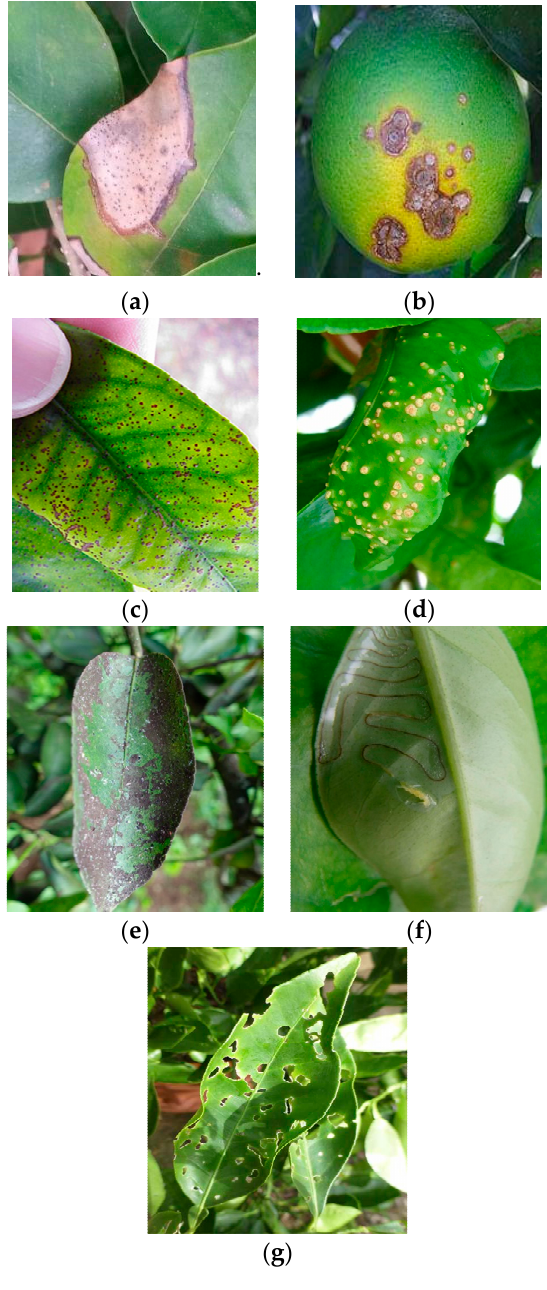
Figure 3. Representative images of citrus diseases. ( a ) citrus anthracnose, ( b ) citrus canker, ( c ) citrus melanose, ( d ) citrus scab, ( e ) sooty mold, ( f ) leaf miner, and ( g ) pest holes.